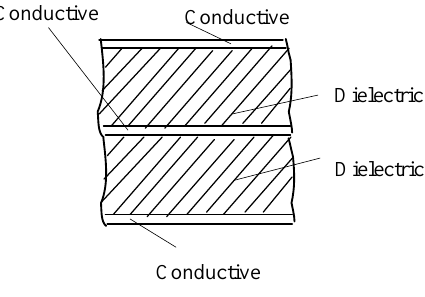
Figure 1. Mechanical construction of the capacitive flexible weighing